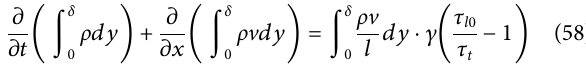
FIGURE 6 | Pro fi le of particle swarm velocity distribution and diagram of momentum